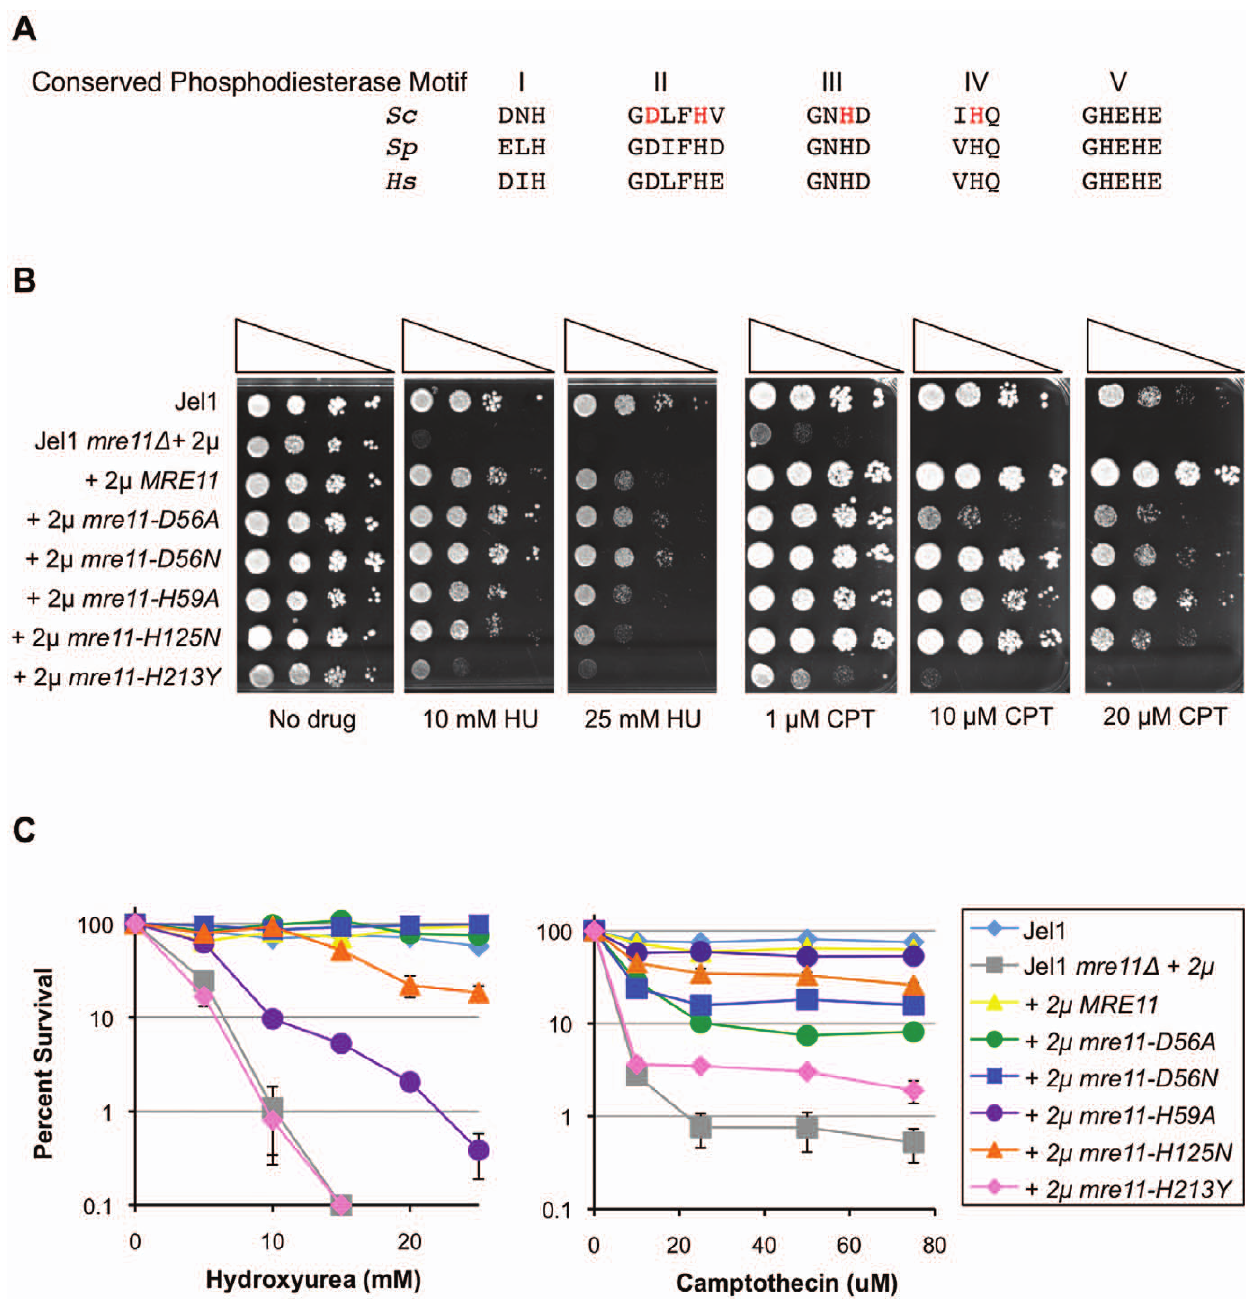
Figure 1. The mre11-H59A allele confers sensitivity to HU but not CPT. A. Conserved phosphodiesterase motifs in the active site of the Mre11 protein. Sequences of conserved amino acid residues in Motifs I–V are shown for three different organisms: S. cerevisiae ( Sc ), S. pombe ( Sp ), and Homo sapiens ( Hs ). Effects of mutations at S. cerevisiae residues shown in red in were tested in experiments described herein. The lengths of the Mre11 polypeptides are all different, and positions of the conserved residues in each motif are shown below for reference: Sc , I, H18; II, D56, H59; III, H125; IV, H213; V, H241, H243; Sp , I, H13; II, D65, H68; III, H134; IV, H222; V, H250, H252; Hs , I, H22; II, D60, H63; III, H129; IV, H217; V, H245, H247. B. Serial spot dilution assays of sensitivity to HU and CPT of S. cerevisiae wild-type parental line Jel1 (Jel1); or its MRE11 -deficient derivative, Jel1 mre11 D , stably transformed with 2 m plasmid vectors expressing protein as indicated, including empty vector (Jel1 mre11 D + 2 m ), wild-type MRE11 ( + 2 m MRE11 ), or indicated mutant alleles ( + 2 m mre11-D56A , + 2 m mre11-D56N , + 2 m mre11-H59A , + 2 m mre11-H125N , + 2 m mre11-H213Y ). Cells were spotted at 10-fold serial dilutions (indicated by triangles) on rich plates containing no drug (left) or indicated concentrations of HU or CPT. C. Clonogenic survival assays of sensitivity to HU and CPT. Strains were assayed for colony formation at indicated doses of each compound. Survival was normalized to untreated samples; error bars indicate standard error of the mean.